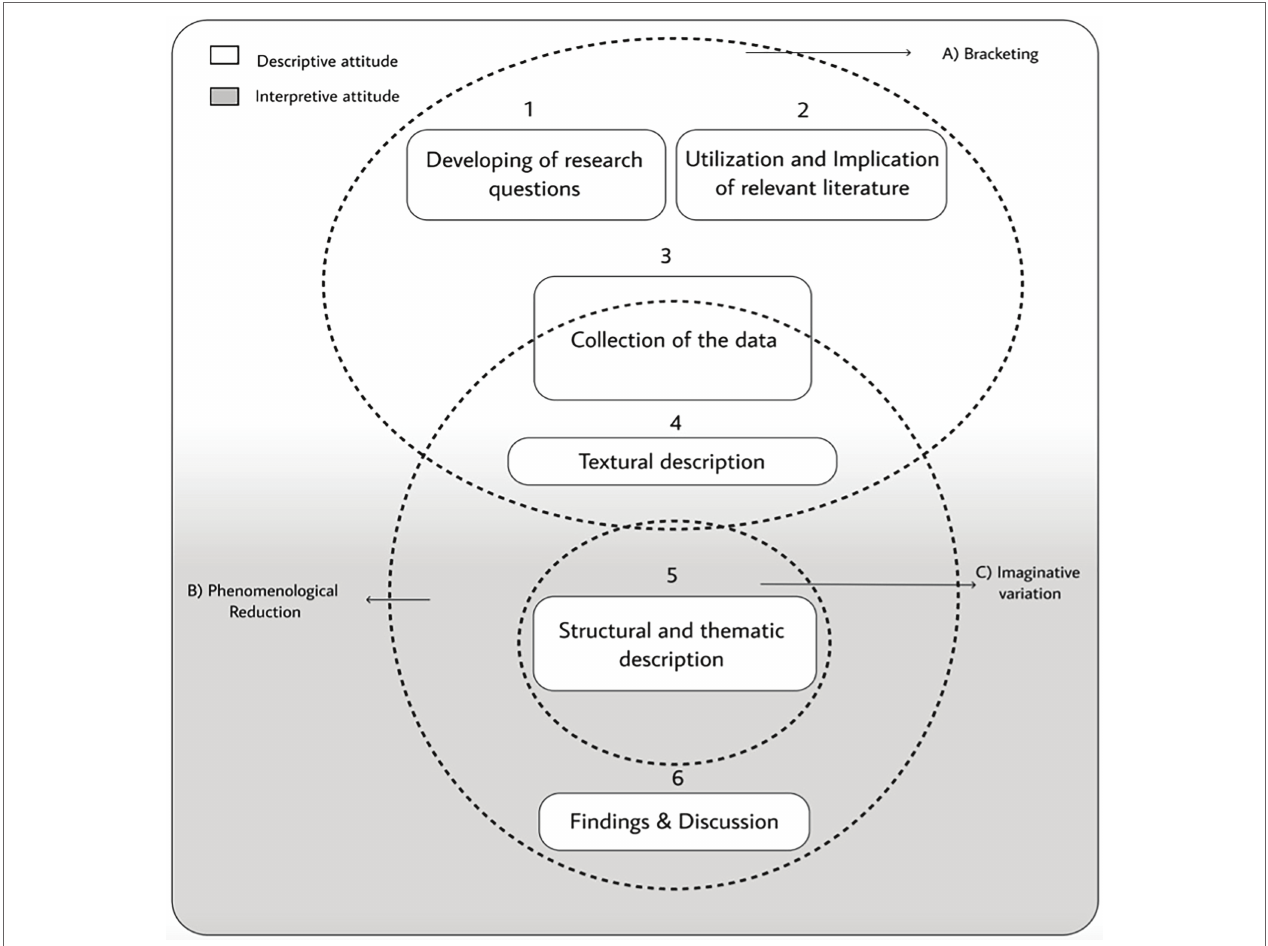
FIGURE 1 | The hybrid phenomenological qualitative